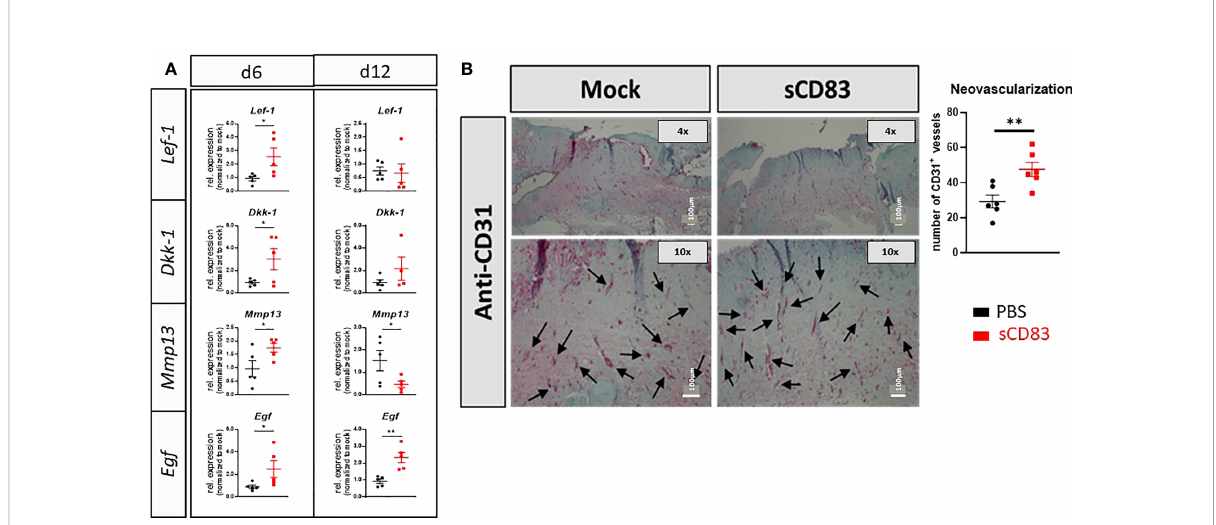
FIGURE 4 sCD83 promotes epithelial stem cell activity during wound healing processes. (A) RT-PCR analyses were performed on day 6 and day 12 using wound biopsies from sCD83- or mock-treated mice with n ≥ 5. (B) Blood vessel formation was assessed by immunohistochemical stainings, using a CD31-speci fi c antibody. Vessel are highlighted by arrows along with the graphical representation of CD31 + vessels right-hand side; n=6). Data are illustrated as mean ± SEM. Statistical analyses were performed using Mann-Whitney test. Asterisks mark statistically signi fi cant difference (*p< 0.05 and **p< 0.01). The absence of asterisks indicates that there is no statistical signi fi